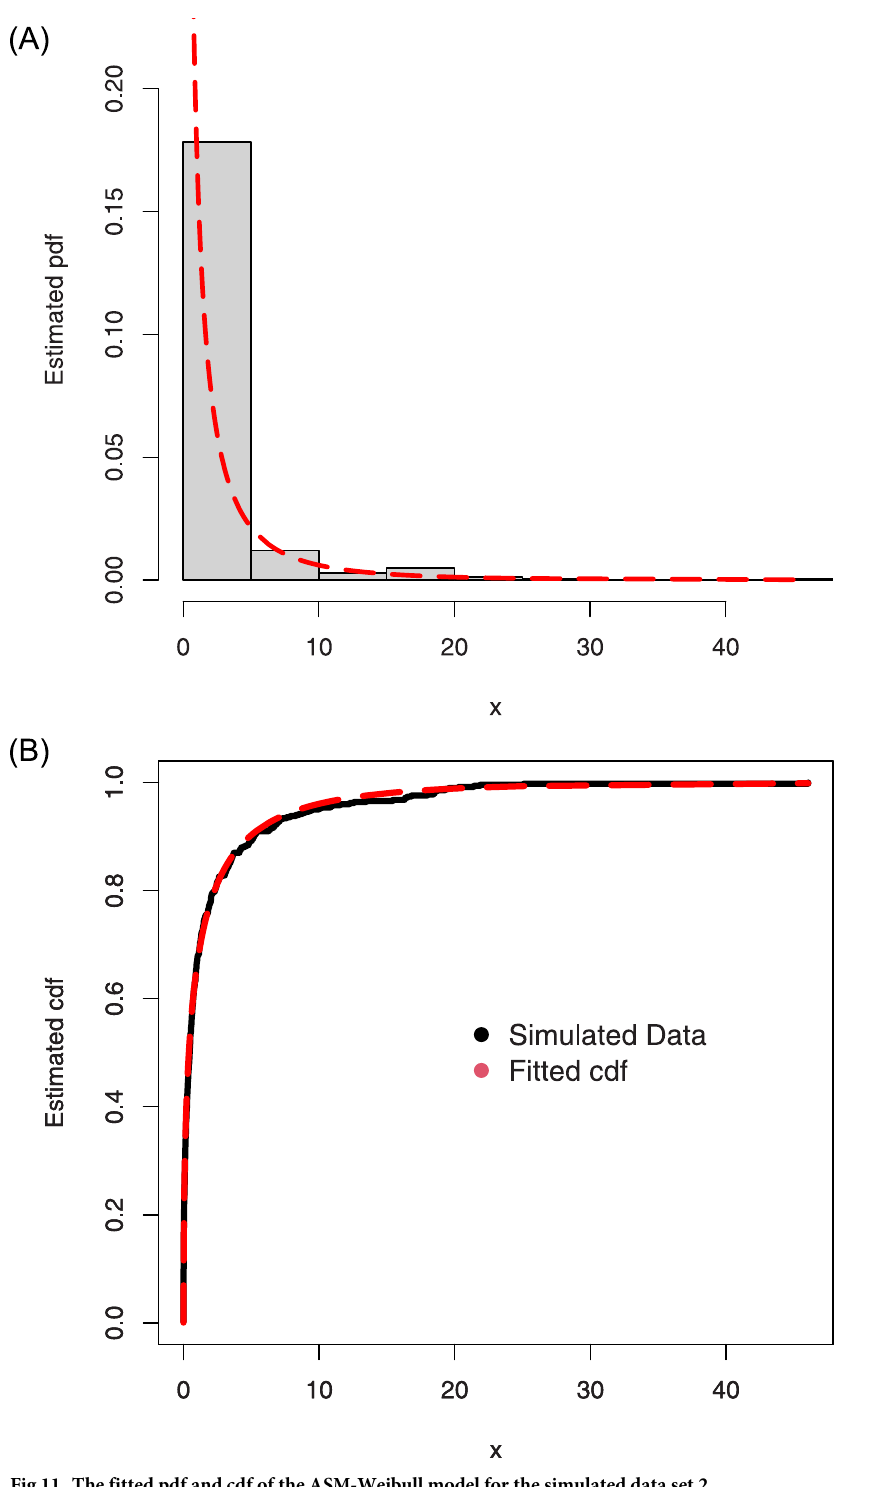
Fig 11. The fitted pdf and cdf of the ASM-Weibull model for the simulated data set 2.